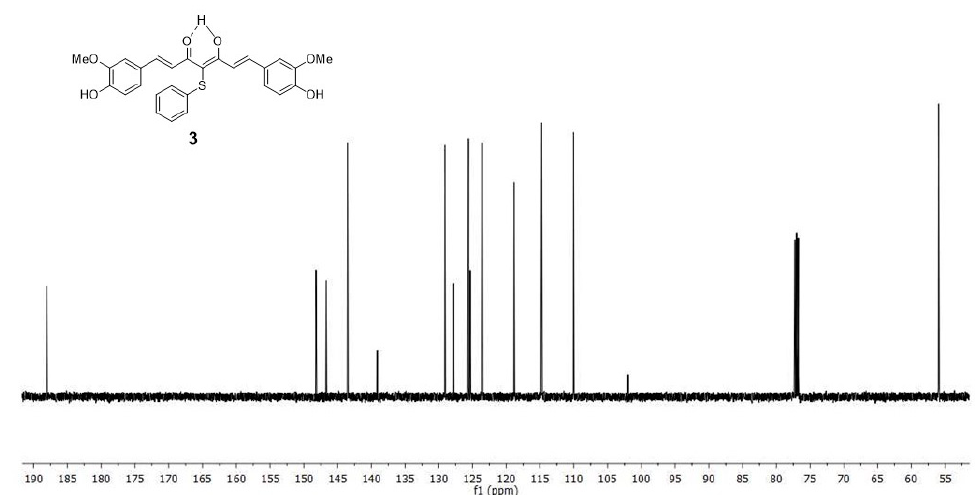
Figure 12. 13 C NMR spectrum of Compound 3 in CDCl 3 as solvent.